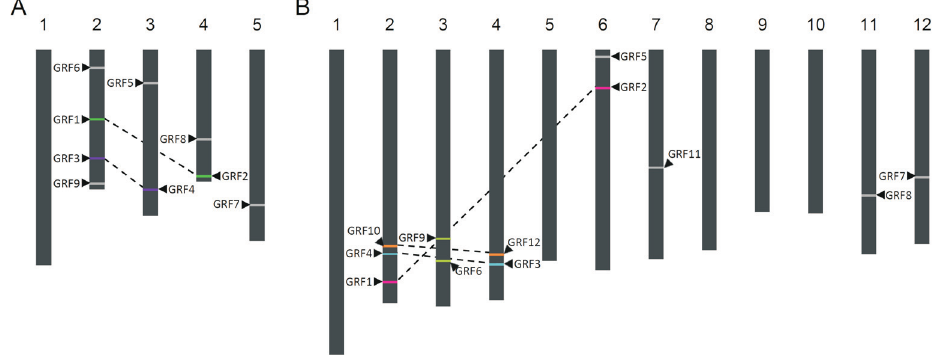
Figure 8 - Distribution of GRFs in nuclear chromosomes of Arabidopsis and rice . The positions of the GRFs from (A) Arabidopsis and (B) rice are indi- catedbyarrows.Genesinduplicatedregionsarerepresentedwiththesamecolors.Genesnotduplicatedarerepresentedingray.Duplicatedregionsindif- ferent chromosomes are linked with dashed